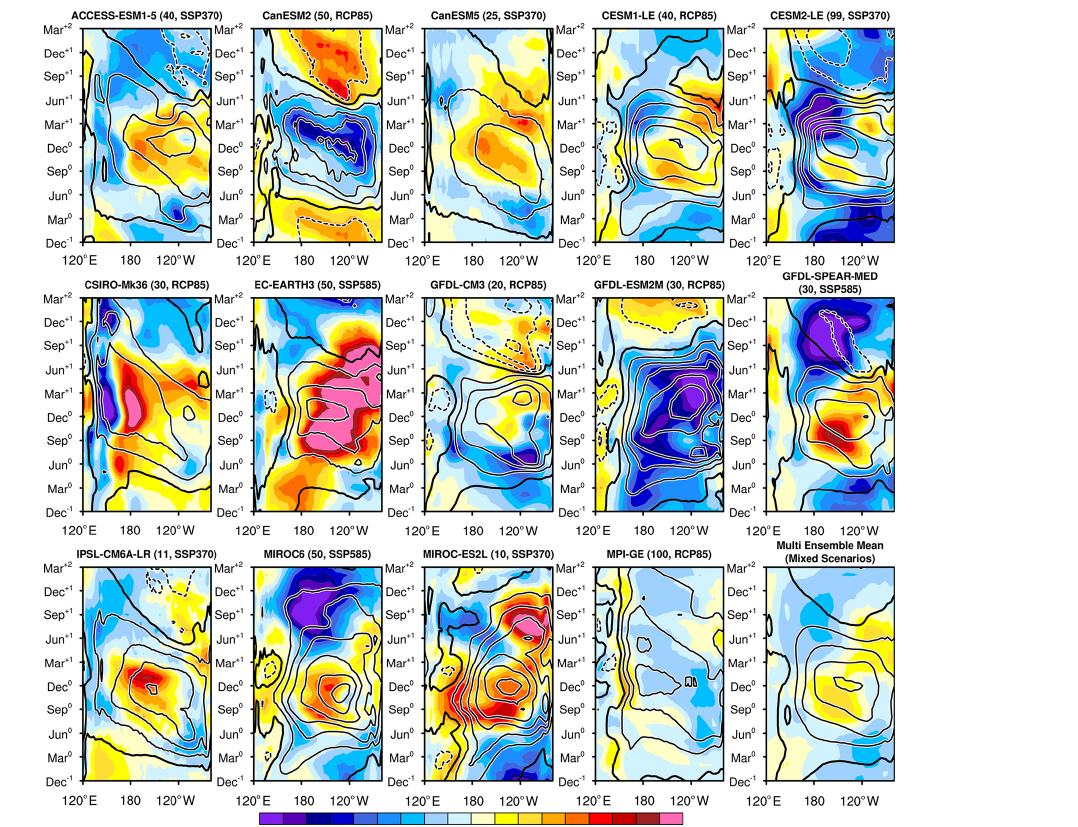
Figure 3. Longitude–time sections of the difference of equatorial Pacific (5 ◦ S–5 ◦ N) SST anomalies ( ◦ C; shading) composited for El Niño events during 2070–2099 compared to 1951–1980 in 14 SMILEs and the multi-ensemble mean. The SST anomalies for El Niño events during 1951–1980 are overlaid ( ◦ C; contours at intervals of 0.4 ◦ C; zero contours thickened and negative contours dashed). El Niño events are defined when the Niño3.4 index exceeds 0.75 standard deviations in Dec 0 but not in Dec − 1 . Monthly SST anomalies are calculated by removing the ensemble mean from individual ensemble